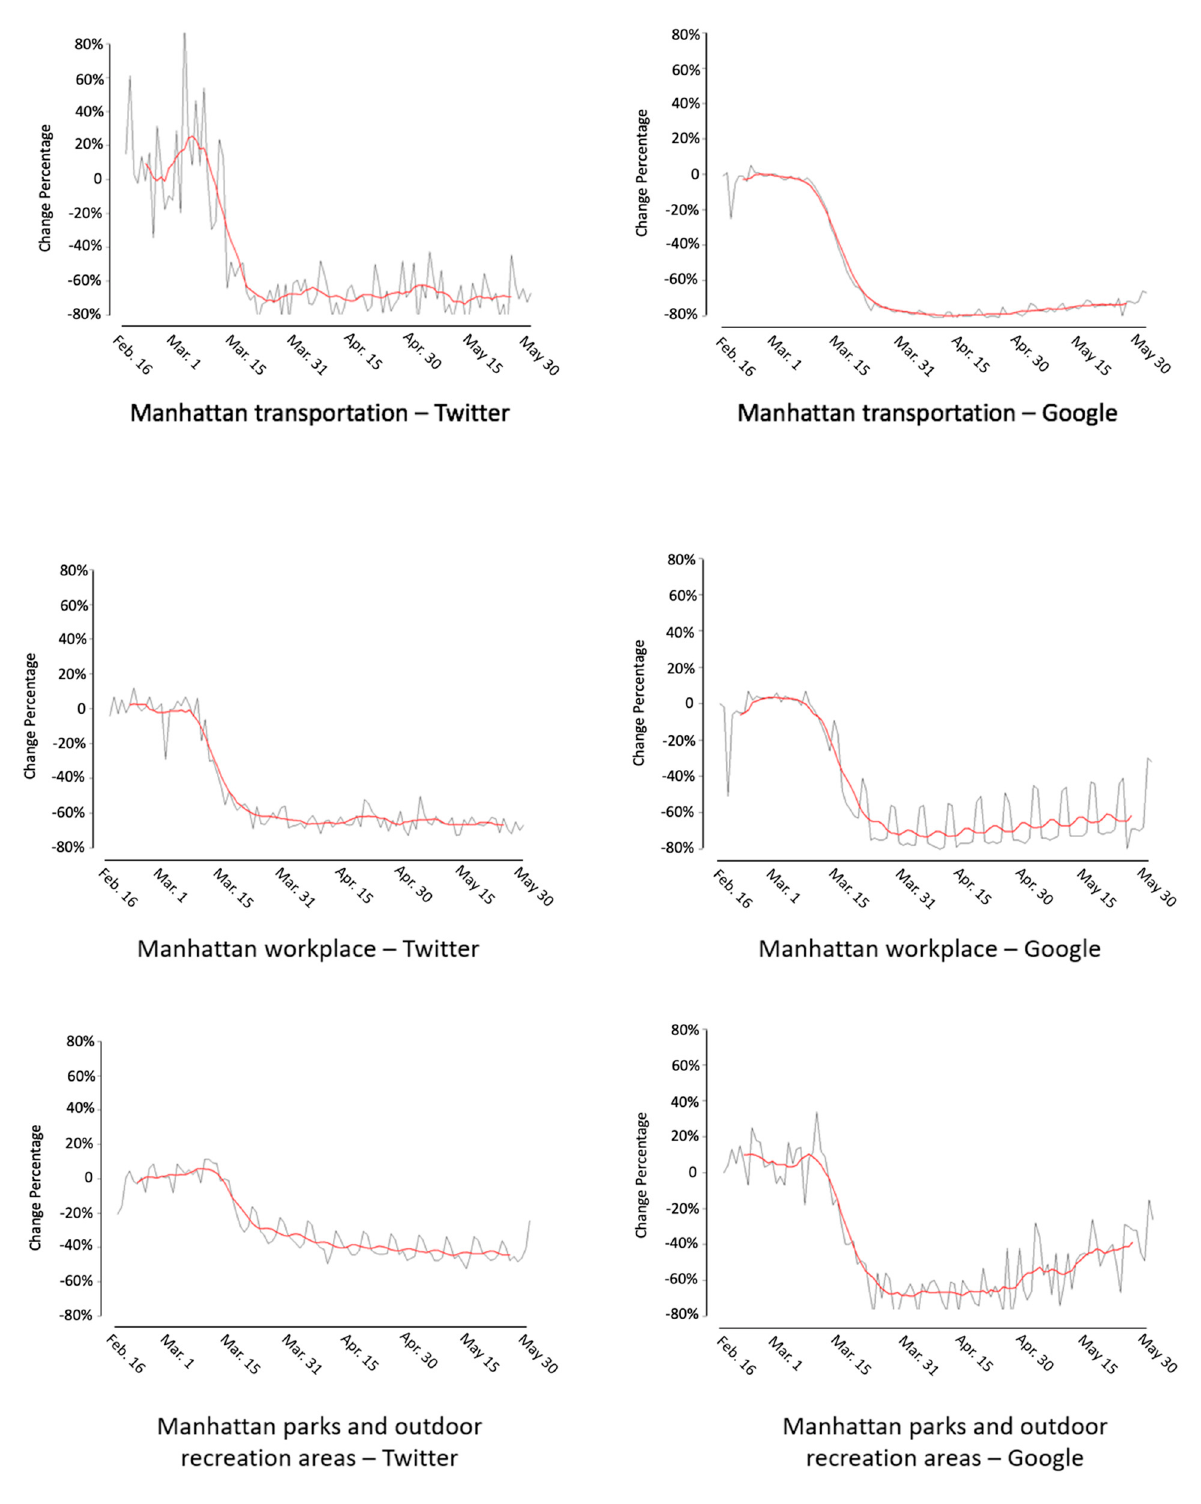
Figure 6. Twitter- and Google-based human mobility changing patterns in New York County.